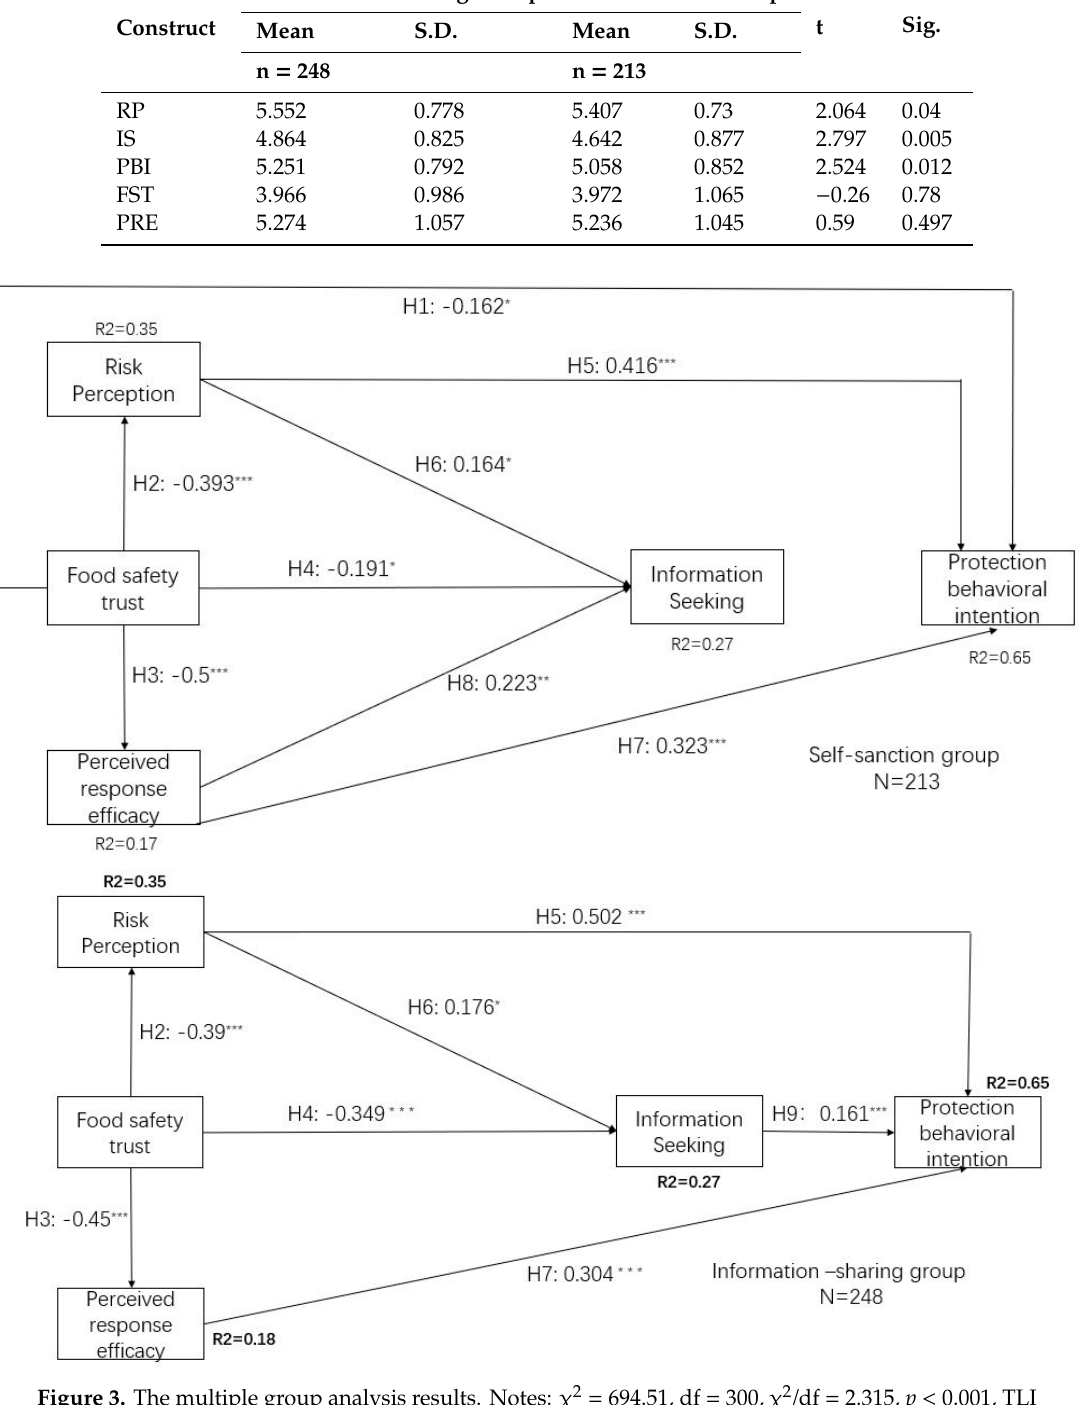
Figure 3. The multiple group analysis results. Notes: χ 2 = 694.51, df = 300, χ 2 / df = 2.315, p < 0.001, TLI = 0.918, NFI = 0.901, CFI = 0.935, RMSEA = 0.054, and RMR = 0.078. Only paths with CR > 2.0 are demonstrated here. * p < 0.05, t > 1.96; ** p < 0.01, t > 2.58; *** p < 0.001, t > 3.29.